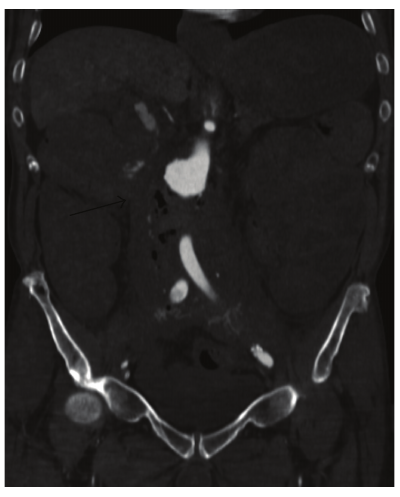
Figure 3: Coronal contrast-enhanced CT scan of